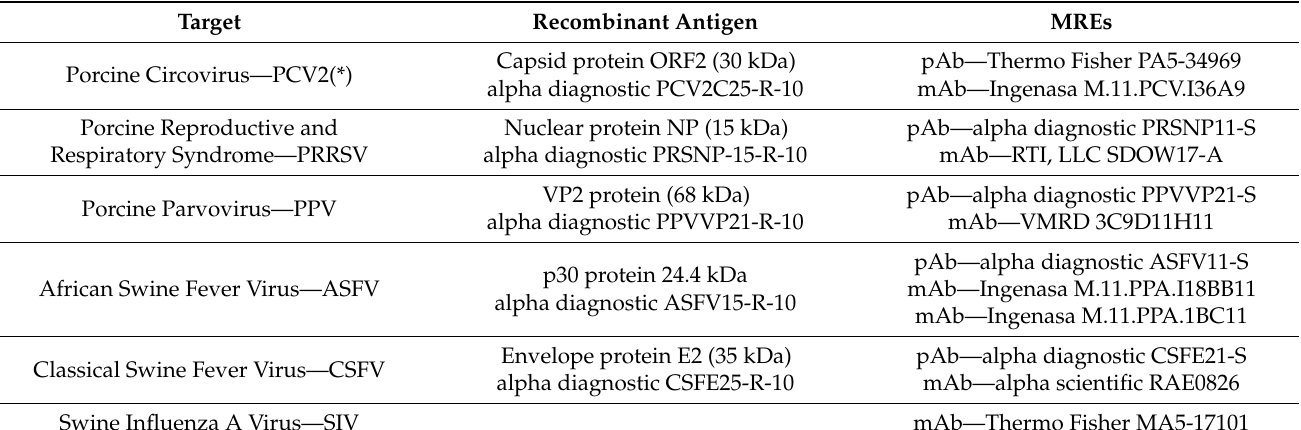
Table 1. Summary of the viruses targeted, the recombinant antigens, and the corresponding MREs for their proper detection. (*) Dilutions tests have already been reported